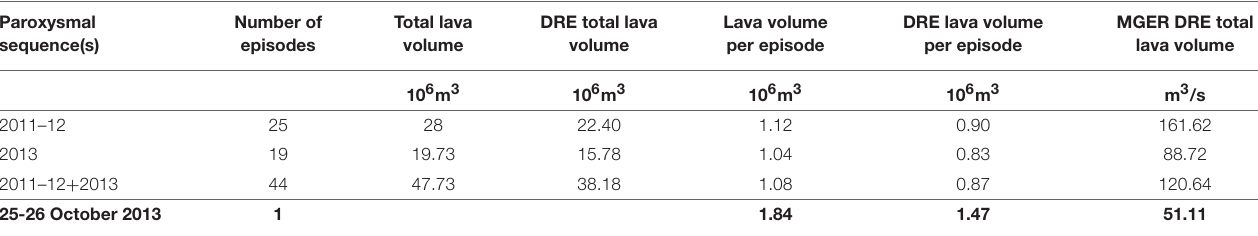
TABLE 4 | Volcanological parameters of the NSEC cone during the 2011–12 and 2013 lava fountaining sequences, and the single 25-26 October 2013 paroxysm. Paroxysmal